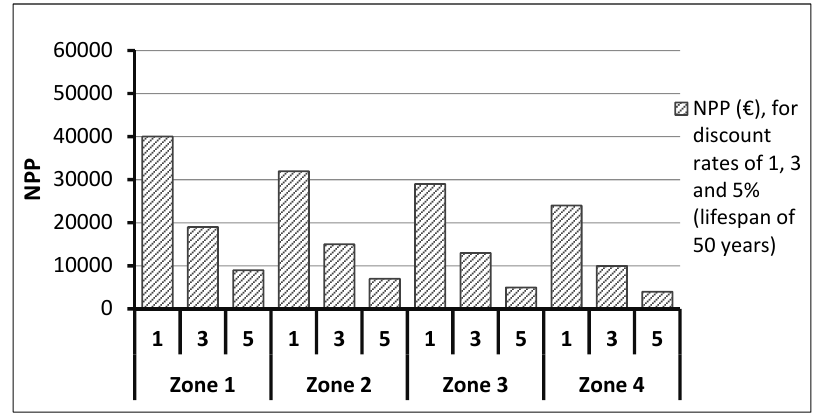
Figure 16. The cost ‐ effectiveness of attic floor energy renovation, corresponding to the optimum measures.